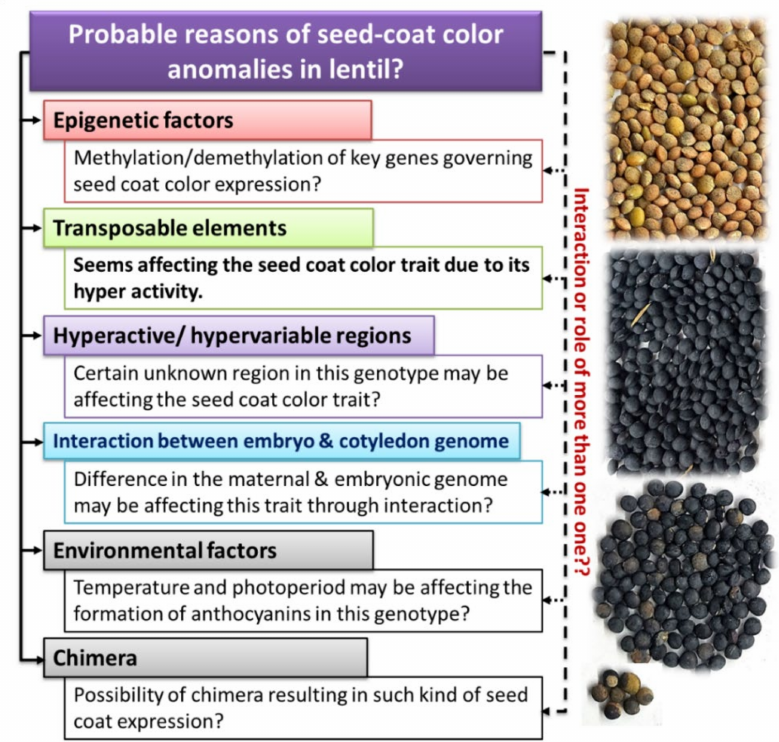
Figure 10. The probable reasons for seed-coat color anomalies in lentil genotype L4717-NM. Supplementary Materials: The following supporting information can be downloaded at